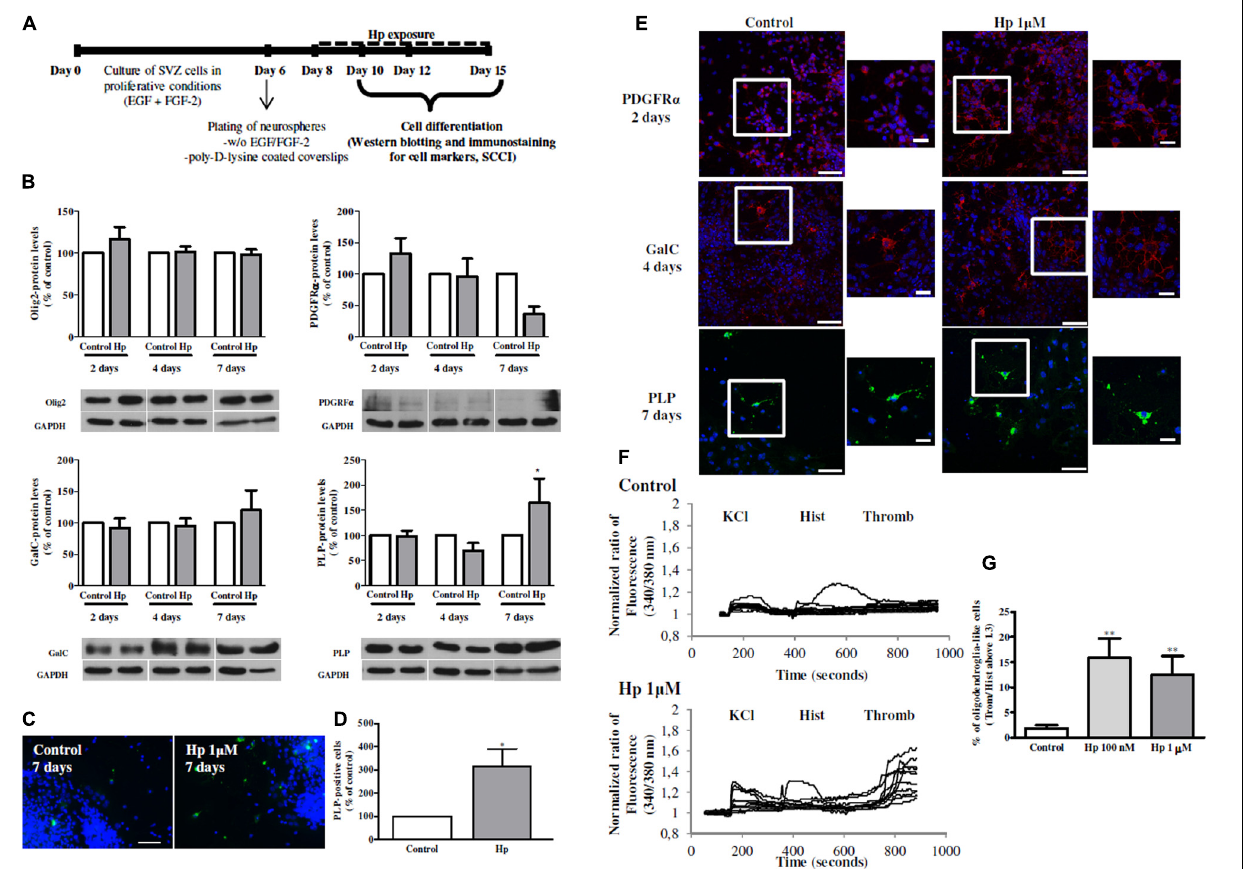
for comparison with control culture. (E) Representative confocal digital images of PDGFR α , GalC and PLP in control cultures and in cultures treated with Hp 1 μ M for 2, 4, and 7 days of differentiation, respectively. PDGFR α (in red); GalC (in red), PLP (in green), and Hoechst 33342 (used to visualize cell nuclei, in blue). Scale bars = 50 μ m. Squares are plans of higher magnifications. Scale bars = 20 μ m. (F) : Representative single cell calcium imaging (SCCI) profiles of response of 8–10 cells in a control culture (no drug exposure) and, in a culture treated with Hp (1 μ M) for 7 days. (G) Bar graph depicts the percentages of oligodendroglial-like responding cells in SVZ control cultures and in cultures exposed to Hp (100 nm and 1 μ M). Data are expressed as mean ± SEM of 4–7 independent experiments. ** P < 0.01; using Dunnett’s multiple comparison test for comparison with SVZ control cultures.